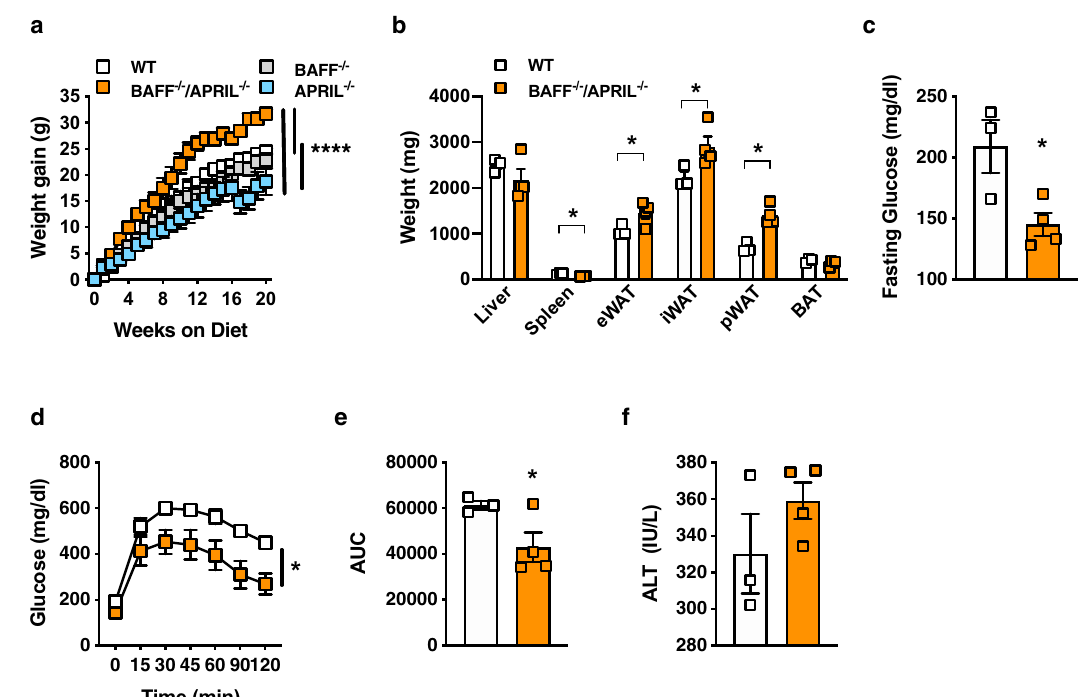
Fig. 6 Lack of BAFF and APRIL exacerbates diet-induced weight gain. a Weight gain of WT, BAFF − / − , APRIL − / − , and BAFF − / − /APRIL − / − mice fed HFD for 20 weeks. b – f WT and BAFF − / − /APRIL − / − mice fed HFD for 20 weeks. b Tissue weight distribution as indicated at time of harvest. c Fasting glucose at 14 weeks of HFD. d GTT at 14 weeks of HFD. e AUC. f Systemic ALT at time of harvest. a A single experiment, n = 3 – 6/condition. b – f A single experiment, n = 3 – 4/condition. a – f For bar and line graphs, data represent mean±SEM. a , d Area under the curve. b – c , e – f Unpaired two-tailed Student ’ s t test. a – e * p < 0.05, **** p < 0.0001. Source data are provided as a Source data fi